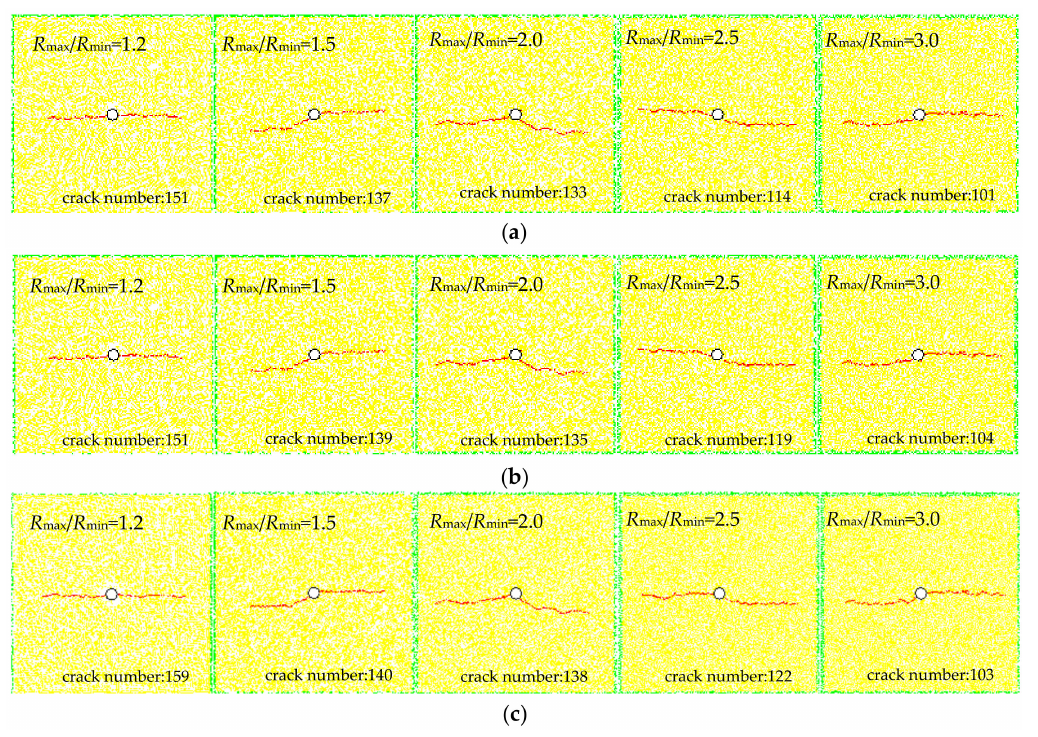
Figure 13. Distributions of hydraulic fractures under different grain size heterogeneity and in-situ stress ratios ( a ) S H / S h = 2; ( b ) S H / S h = 3; ( c ) S H / S h =